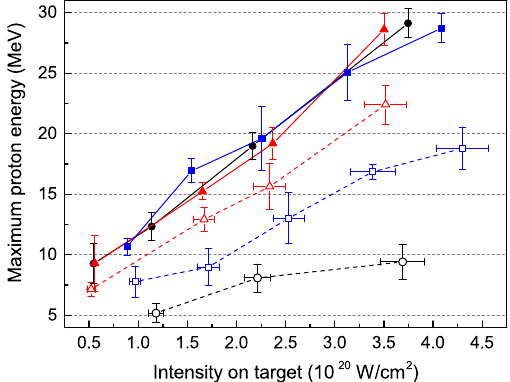
FIG. 2. Energy spectra of the protons obtained with a laser intensity of 4.1, 3.5, 3 . 7 × 10 20 W = cm 2 for s -, p - and c – polarization respectively. The targets are DLT with 8 μ m – thick foam (spectra a, b, c respectively) and ST (spectra d, e and f). The spectra are collected along the target normal direction. The inset shows the electron energy spectra when using DLT with 12 μ m – thick foam with s – , p - and c – polarization, (spectra a, b, c respectively) and using ST for s – and c – polarization (spectra d and f).